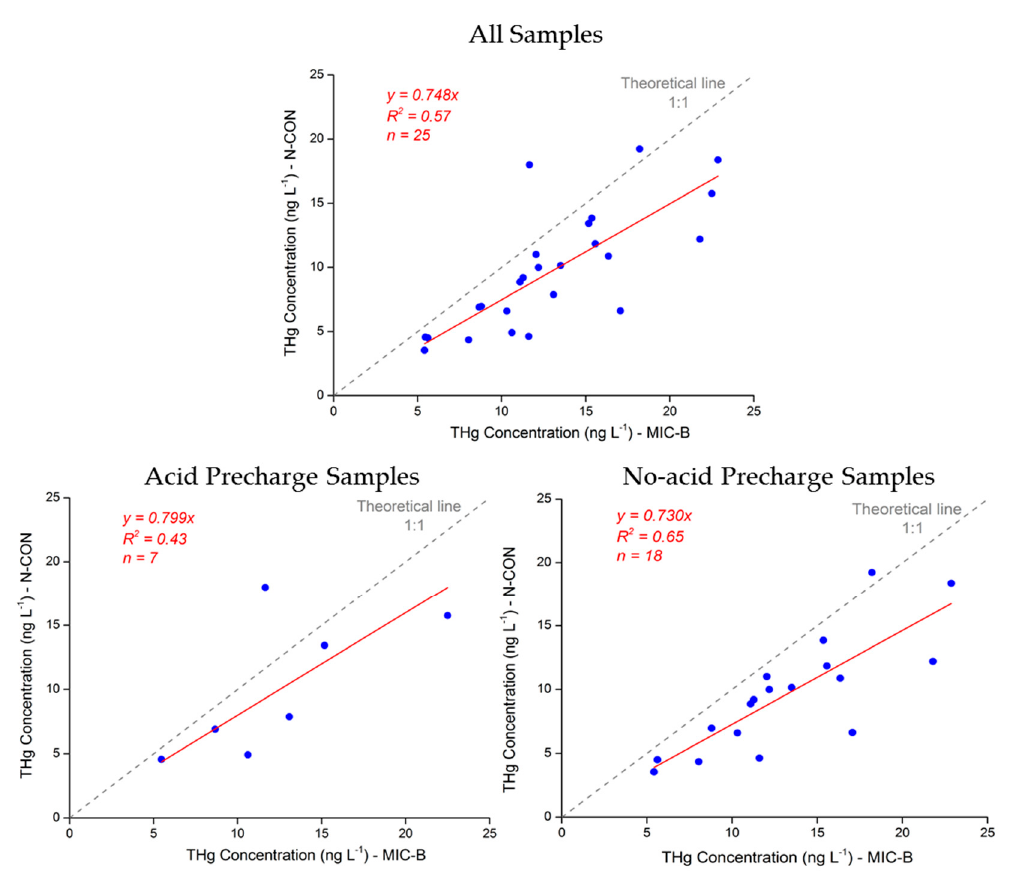
Figure 5. Concentrations measured by collocated samplers using two separate sampler types (NCON and the MIC-B style) at NCU Campus, Taiwan.